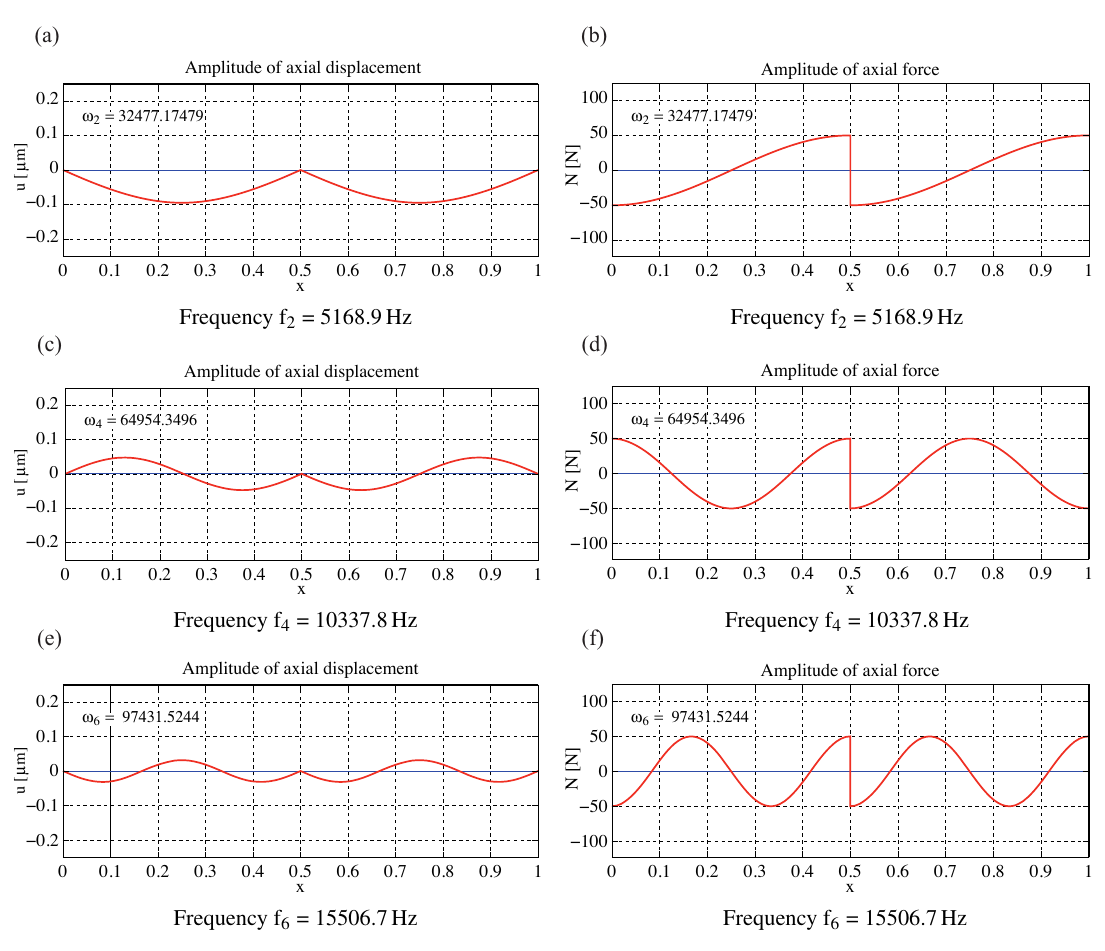
Fig. 9. Axial displacement and force amplitudes at saddle point frequencies. Dynamic vibration absorption.